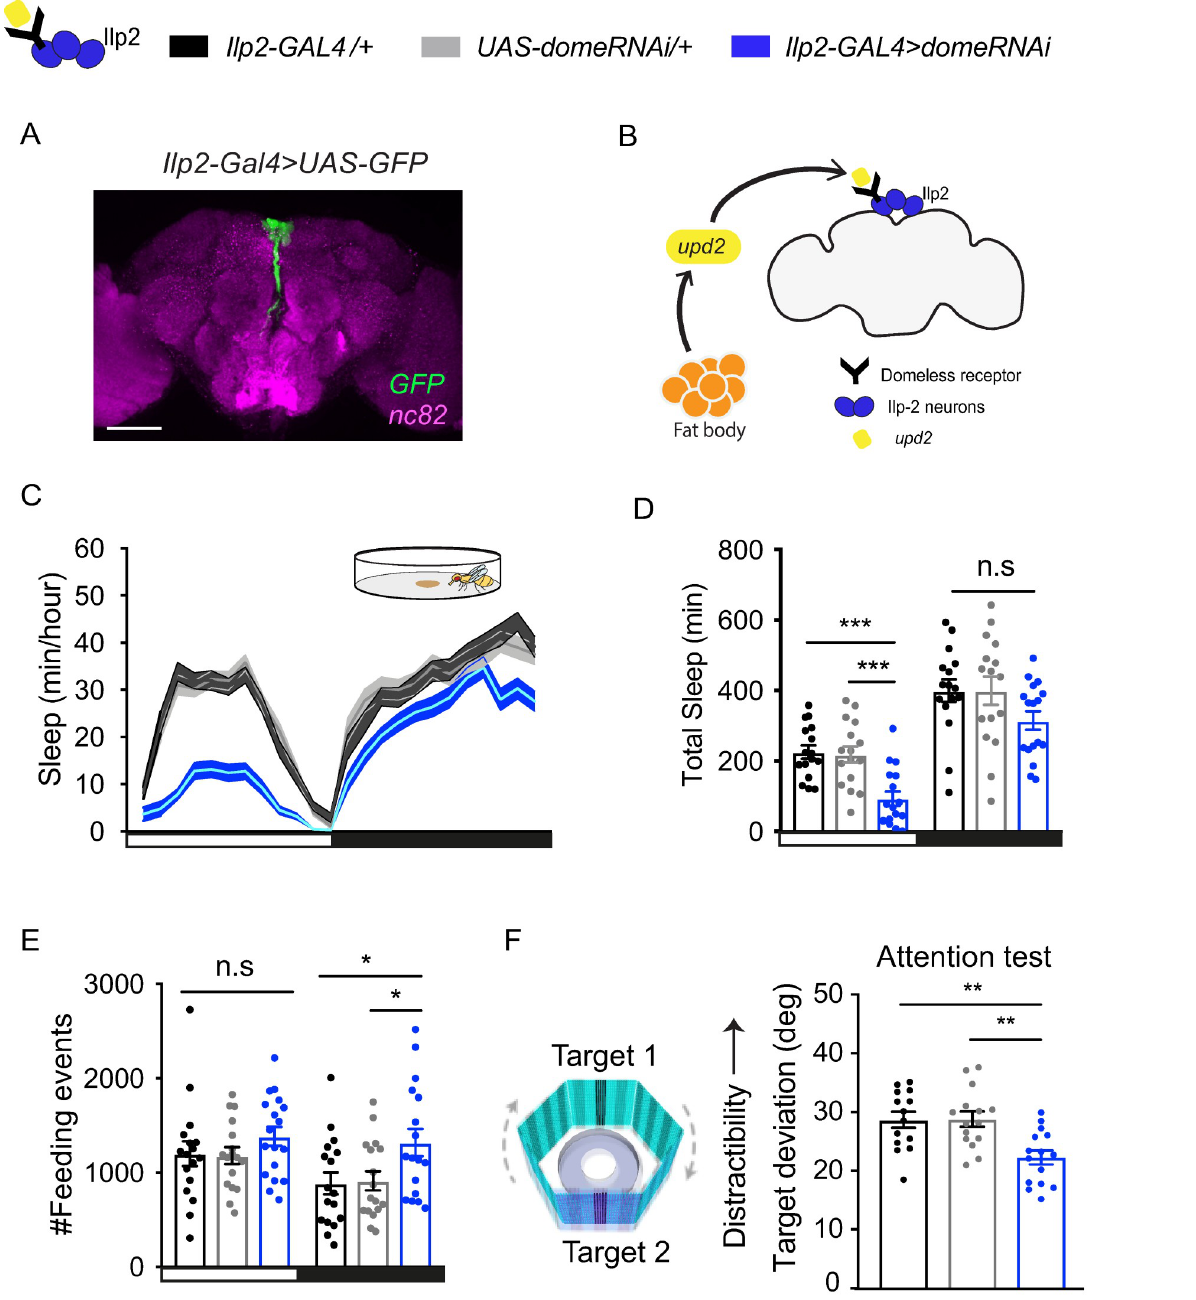
Fig 8. Knockdown of dome , the upd2 receptor, in Ilp2- expressing neurons, recapitulates upd2 knockdown phenotypes. (A) Ilp2-GAL4 neurons are located in the PI region of the brain. Whole-mount brain image, maximum projection, scale bar = 100 μ m. (B) Schema illustrating the integration of upd2 signal via dome receptor in Ilp2 neurons. (C) The 24-hour sleep profile of flies with knockdown of dome receptor in Ilp2 neurons (blue) compared with genetic controls ( Ilp2-GAL4/+ , black; UAS-domeRNAi/+ , light gray). Sleep was measured over 3 days in open-field arenas. (D) Daytime sleep was significantly reduced in knockdown flies, whereas nighttime sleep was not affected. (E) The number of feeding events showed a significant increase at nighttime. (F) Target deviation angle of flies with dome knockdown was significantly lower compared with genetic controls, indicating less distractibility ( n = 13–15). For sleep analysis, 3–5-day-old adult females virgins were used, n = 15–17 per genotype. � P < 0.05, �� P < 0.01, ��� P < 0.001; one-way ANOVA, error bars show SEM. The data underlying this figure can be found in S1 Data. dome , domeless ; GAL4, galactose-responsive transcription factor; GFP, green fluorescent protein; Ilp2, insulin-like peptide 2; PI, pars intercerebralis; RNAi, RNA interference; UAS, upstream activation sequence; upd2 , unpaired 2.